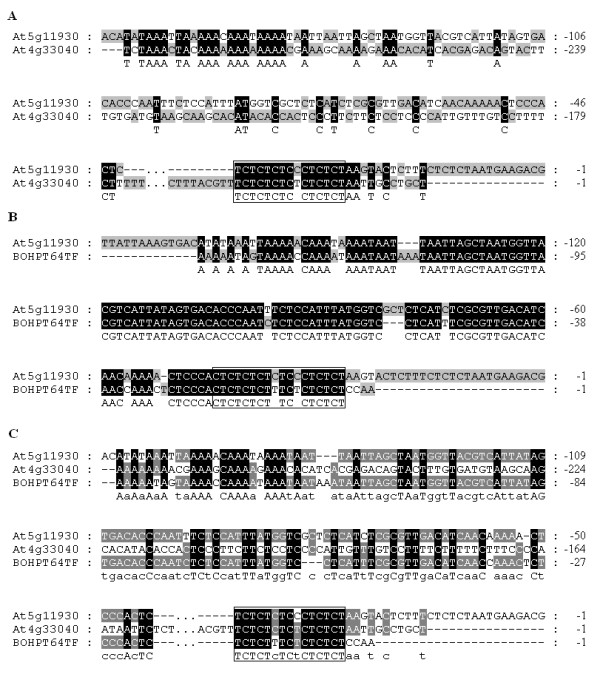
An example of microsatellites conserved among paralogous and orthologous genes. Sequence alignments and positions for the microsatellites conserved among (A) Arabidopsis paralogous genes, (B) Arabidopsis-Brassica orthologous genes and (C) homologous genes from Arabidopsis and Brassica. Boxed regions indicate CNMSs. Dots indicate omits of alignment. Nucleotide positions are given relative to the initiation codon.